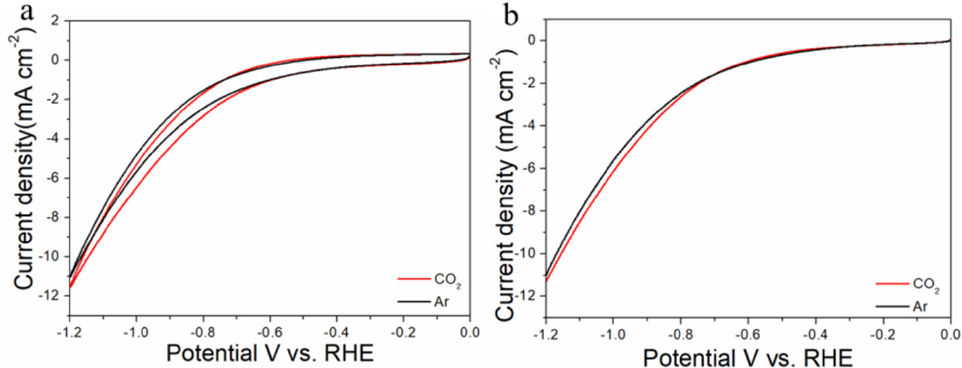
Figure 3. Cyclic voltammograms ( a ) and linear scan voltammograms ( b ) of Au 25 Cu 75 /C in Ar saturated and CO 2 -satruated 0.1 M KHCO 3 solutions collected at a scan rate of 20 mV s − 1 .